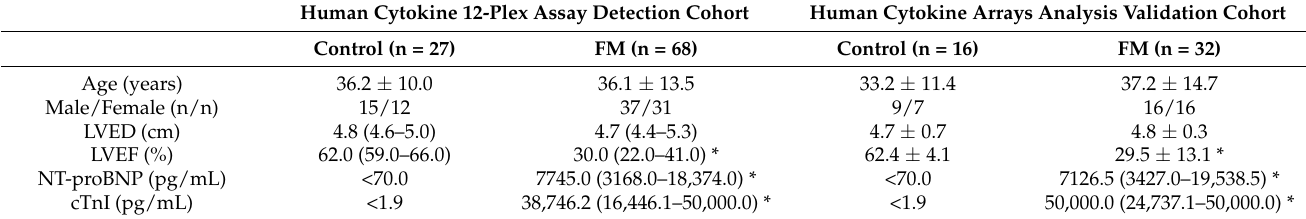
Table 1. Baseline clinical characteristics of human cytokine 12-Plex assay detection cohort and human cytokine arrays analysis validation